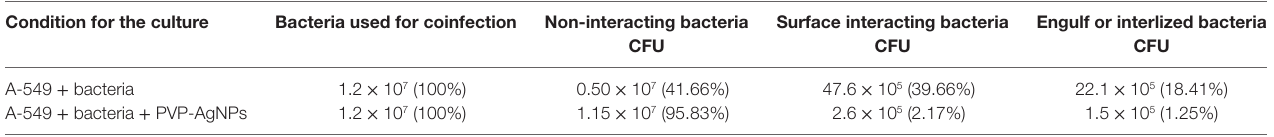
TaBle 1 | Comparative display of colony-forming unit (CFU) counting at different stages of A. baumannii infection in absence and presnce of PVP-capped silver nanoparticles (PVP-AgNPs). condition for the culture Bacteria used for coinfection non-interacting bacteria